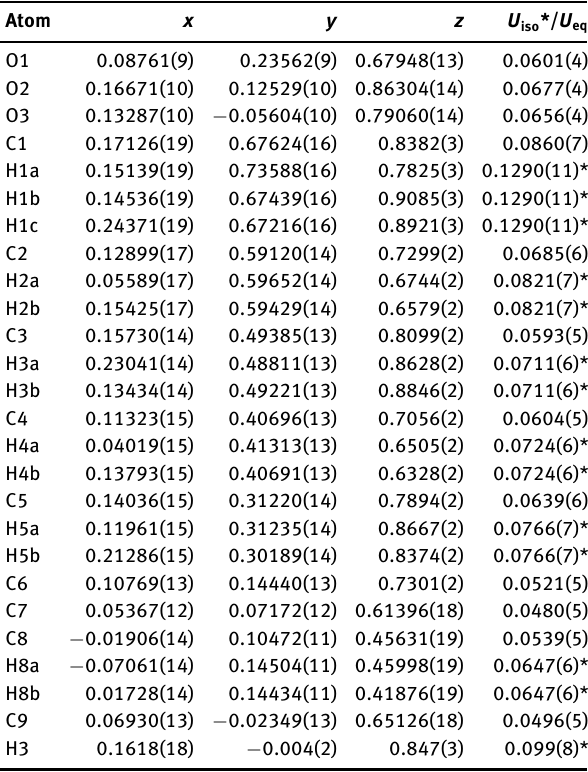
Table 2: Fractional atomic coordinates and isotropic or equivalent isotropic displacement parameters (Å 2